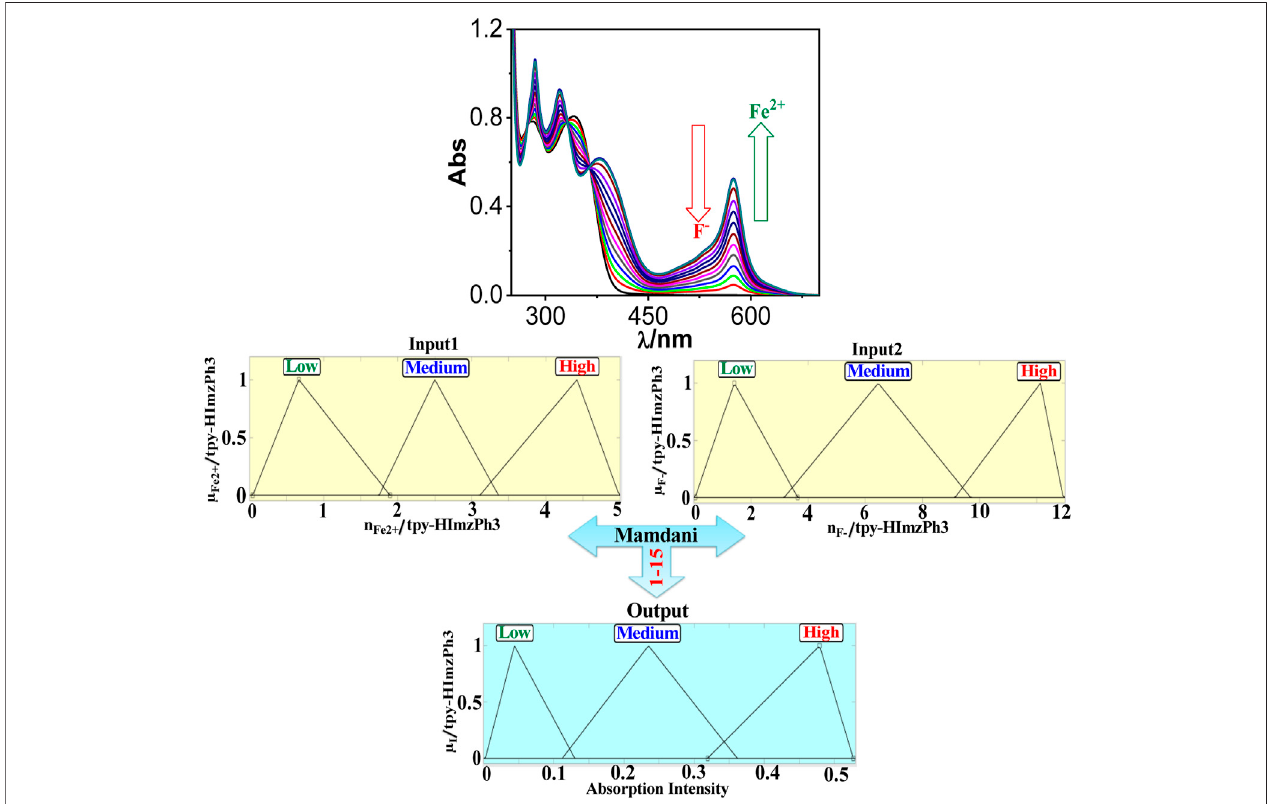
FIGURE 15 | Schematic display of fuzzy logic based on fuzzy inference rules by monitoring absorbance at 575 nm upon the action Fe 2+ and F − as inputs. Fuzzy variables are decomposed into three fuzzy sets. Fe 2+ : (1)low [trimf μ low , (0.042 0.665 1.89)]; (2) medium [trimf μ medium , (1.747 2.51 3.36)]; and (3) high [trimf μ high , (3.109 4.419 4.989)]. F − : (1) low [trimf μ low , (0.0426 1.41 3.633)]; (2) medium [trimf μ medium , (3.16 6.46 9.69)]; and (3) high [trimf μ high , (9.146 12.14 13.01)]. Absorption intensity (output): (1) low [trimf μ low , (0.00253 0.0439 0.1297)]; (2) medium [trimf μ medium , (0.112 0.235 0.361)]; and (3) high [trimf μ high , (0.319 0.479 0.527)].